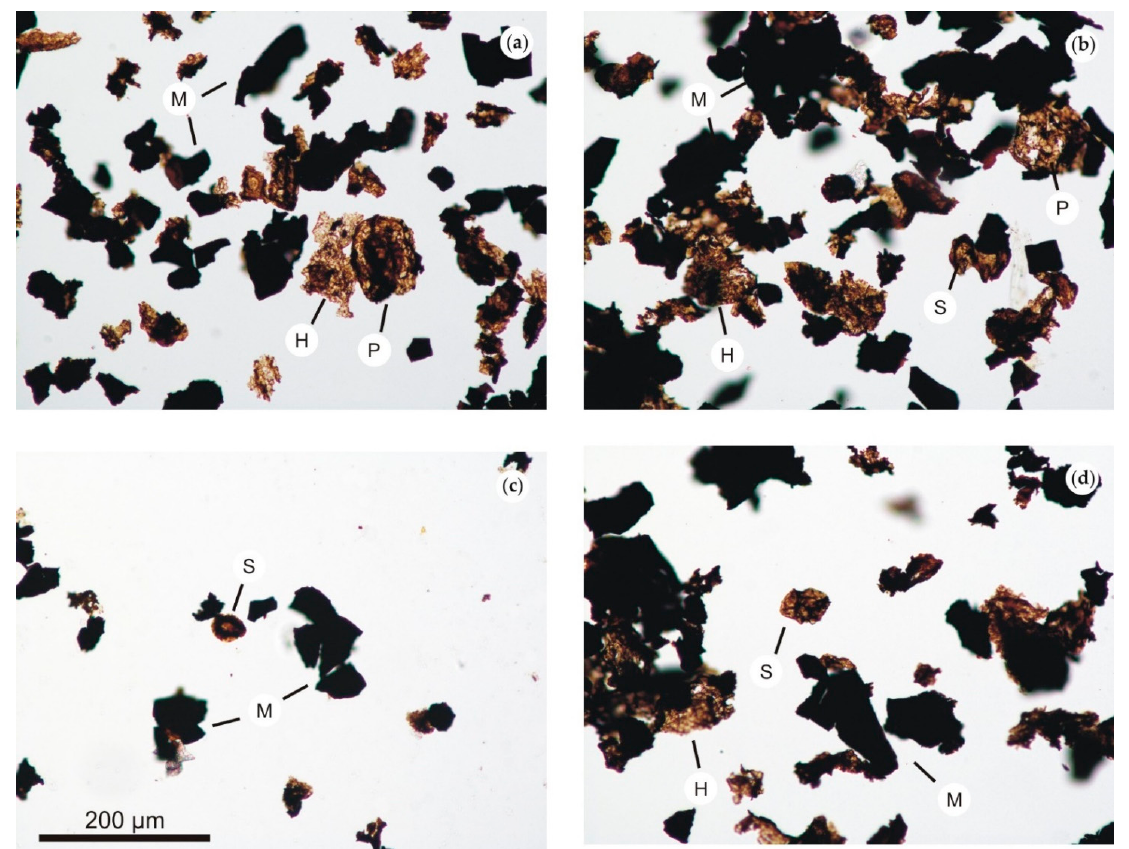
Figure 9. Palynofacies from northern (N samples) and southern (S samples) areas. ( a ) Sample N1; ( b ) sample N3; ( c ) sample S4; ( d ) sample S4. H, hylogen; M, melanogen; S, spora; P, pollen; AOM, amorphous organic matter. Scale bar is the same for all images.